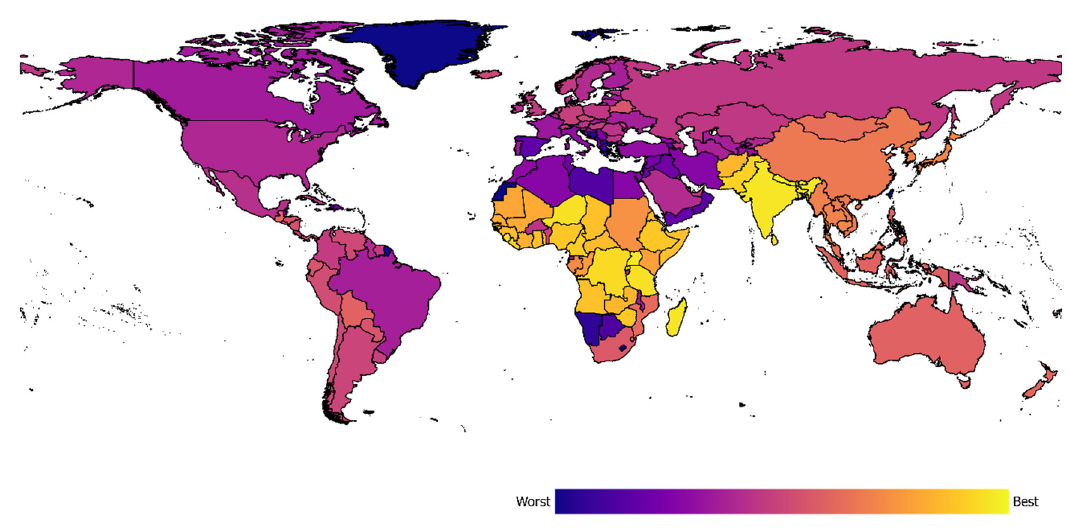
Figure 14. Global view on the employment dimension.